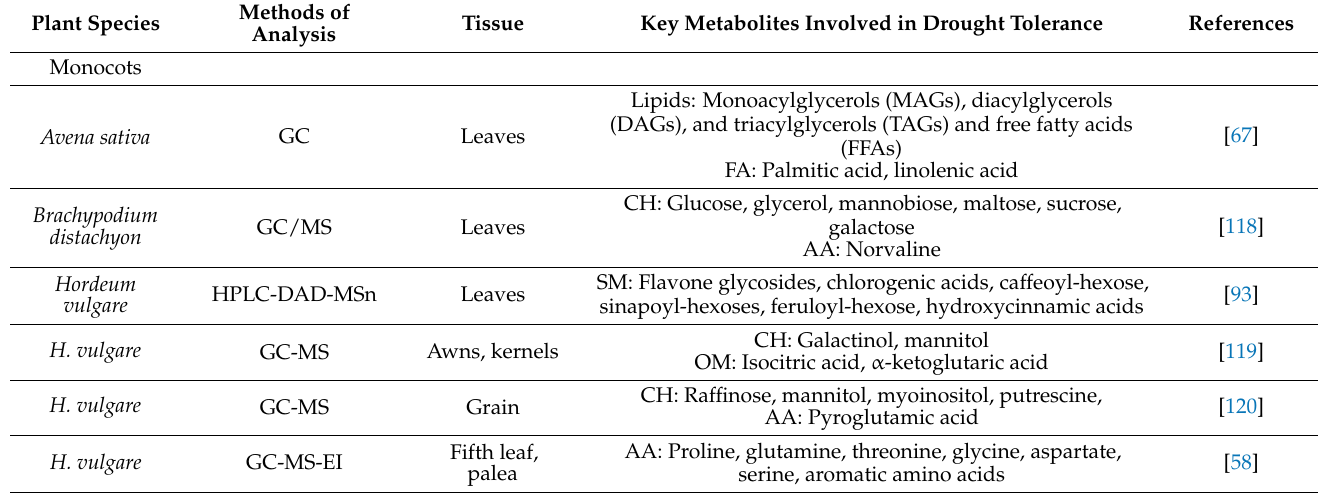
Table 1. Key metabolites involved in various plant species under drought